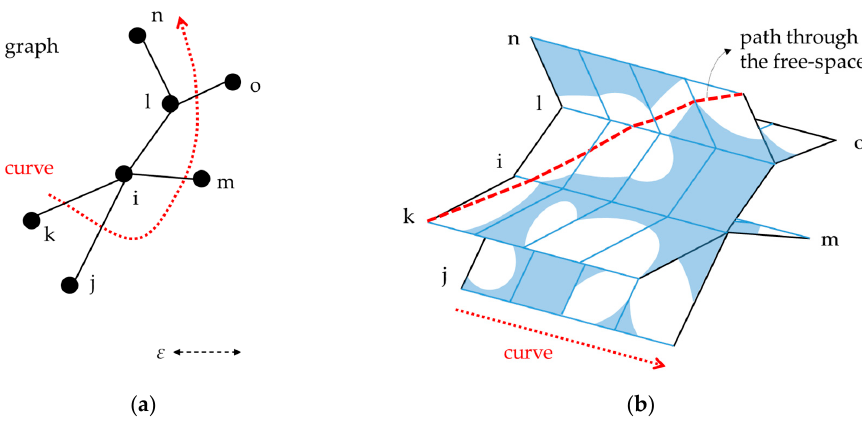
Figure 3. An example of ( a ) a trajectory curve and a graph and ( b ) an extended free-space diagram between them. The shortest path (a thick dashed line in the diagram) becomes the matching result (from [19] and [20]).